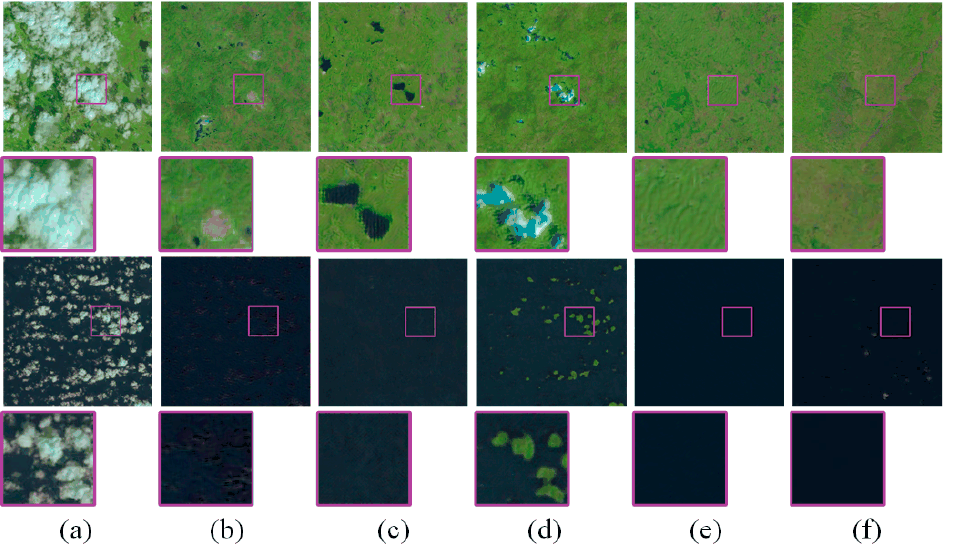
Figure 10. Results of an ablation study of different components of the network architecture on the RICE2 test set. ( a ) Cloudy images; ( b ) baseline; ( c ) baseline + DCM; ( d ) baseline + FRM; ( e ) DC-GAN-CL; ( f ) cloud-free images.